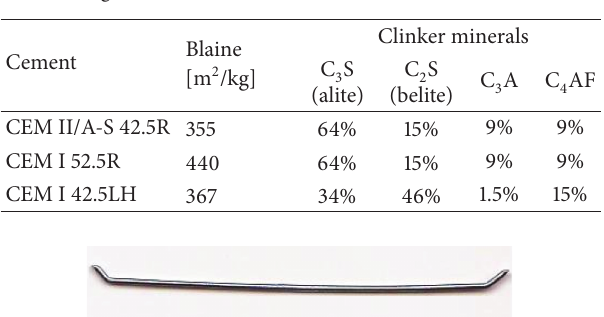
Figure 1: The steel fibre IRI 50/30. Steel fibres were added to some of the concrete